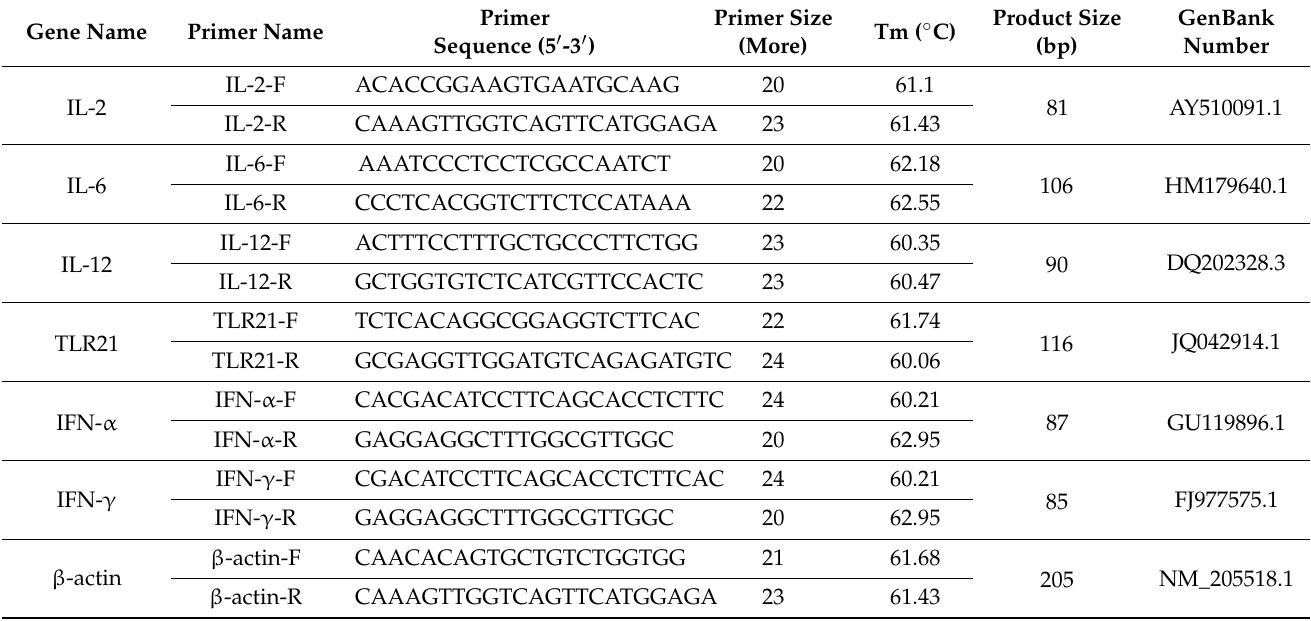
Table 2. Fluorescent quantitative PCR primer